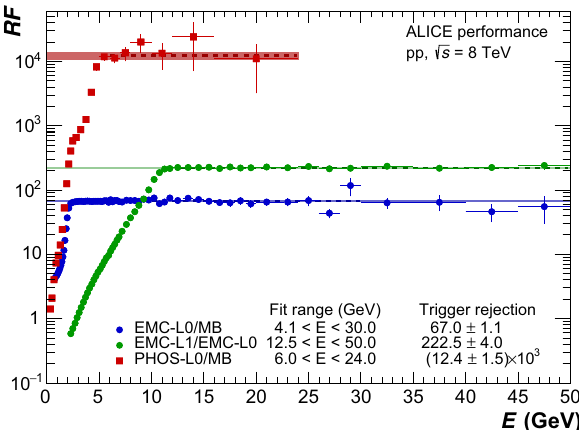
Fig. 1 Determination of RF s for the PHOS-L0 and EMC-L0/L1 trig- gers. In the plateau region, the RF s are obtained by fits of constants in the given cluster energy ranges, illustrated by the dotted lines. The uncertainties of the determined RF s are indicated by light colored uncertainty bands, which are obtained by varying the fit